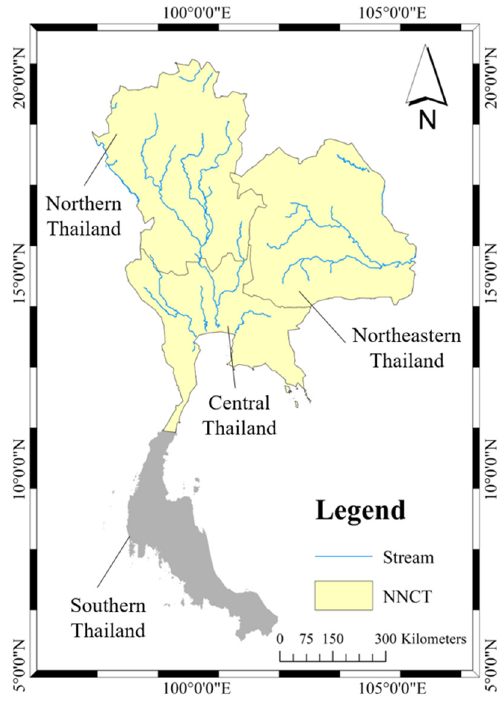
Figure 1. Northern, northeastern, and central Thailand (NNCT).